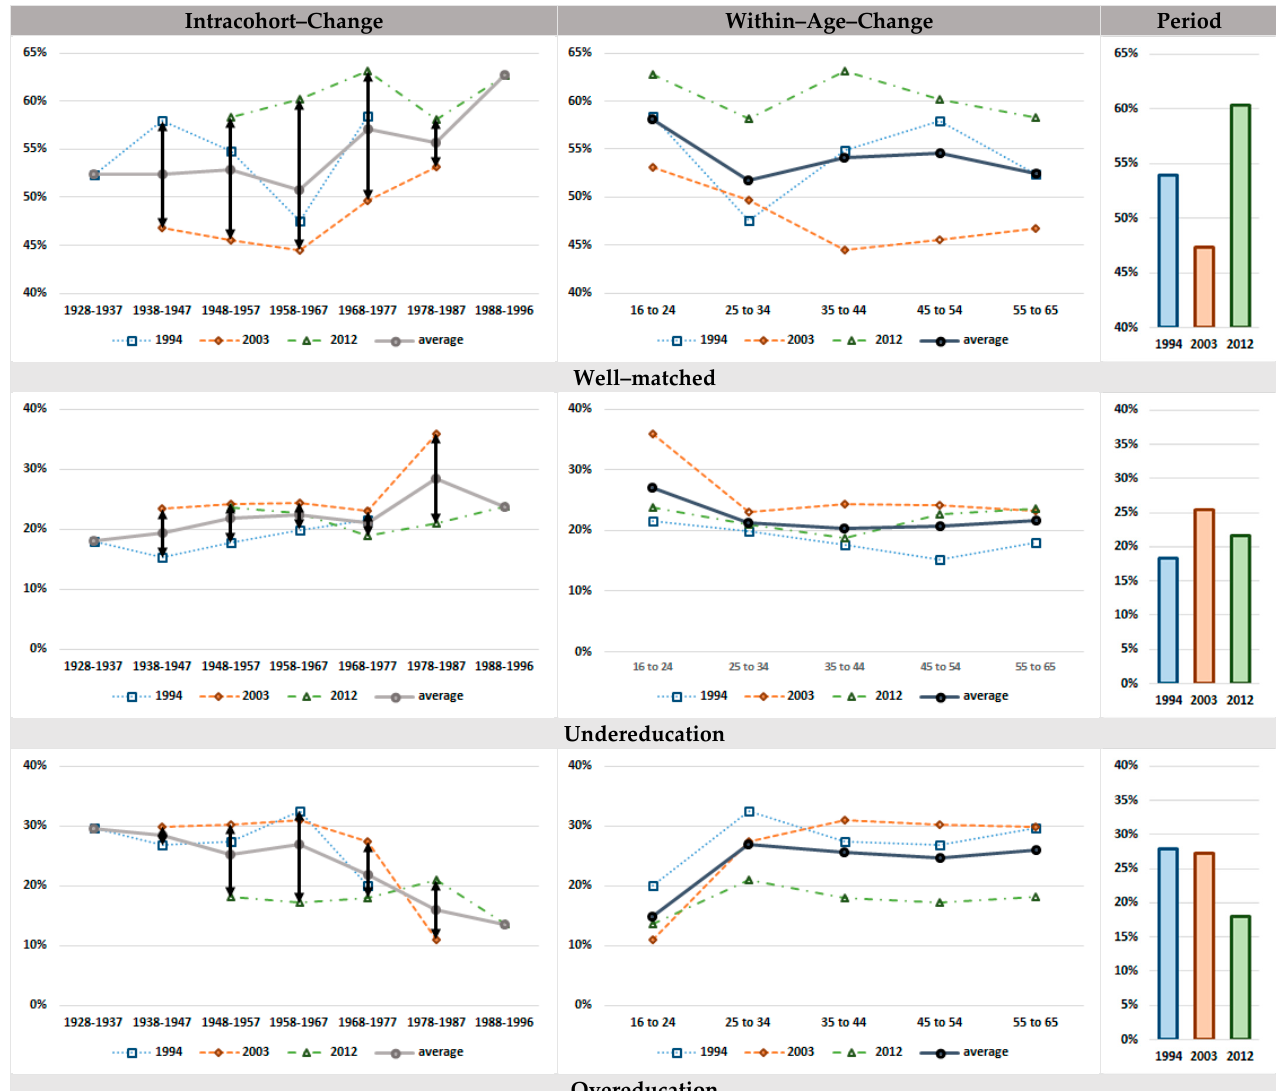
Figure 4. The incidence and change of educational mismatch.